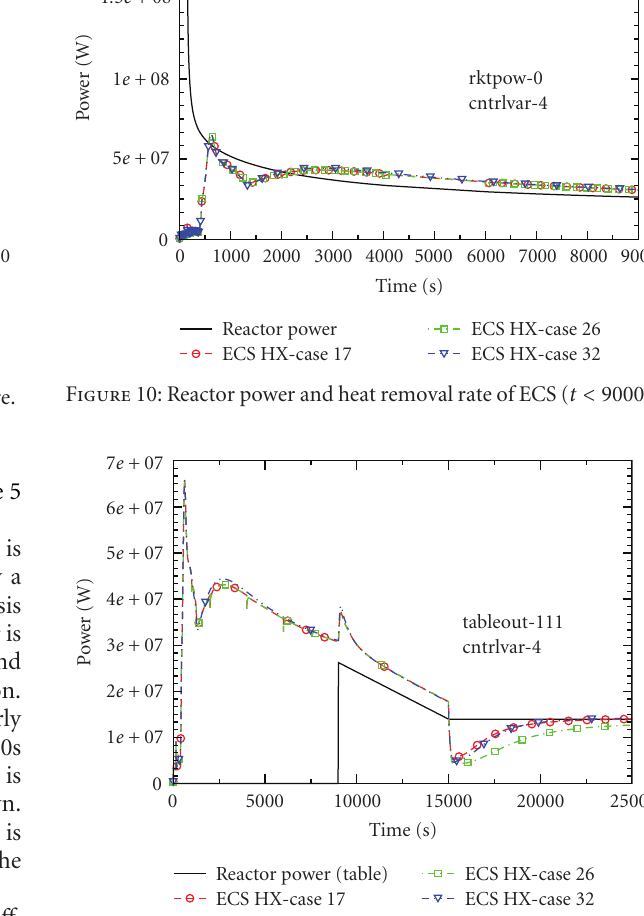
Figure 11: Reactor power and heat removal rate of